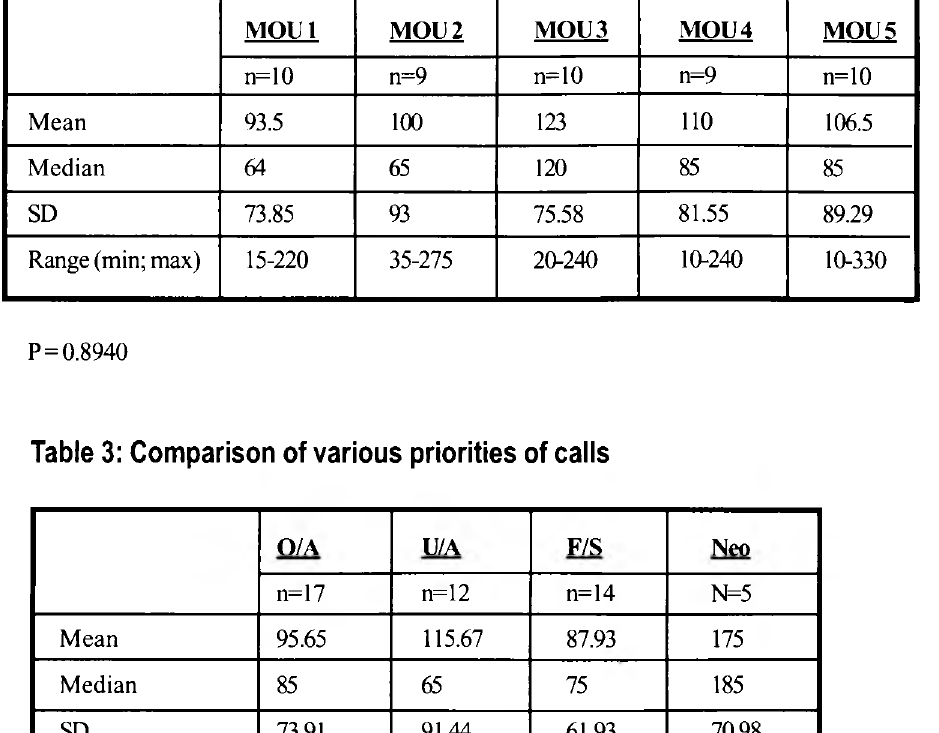
Table 3: Comparison of various priorities of calls